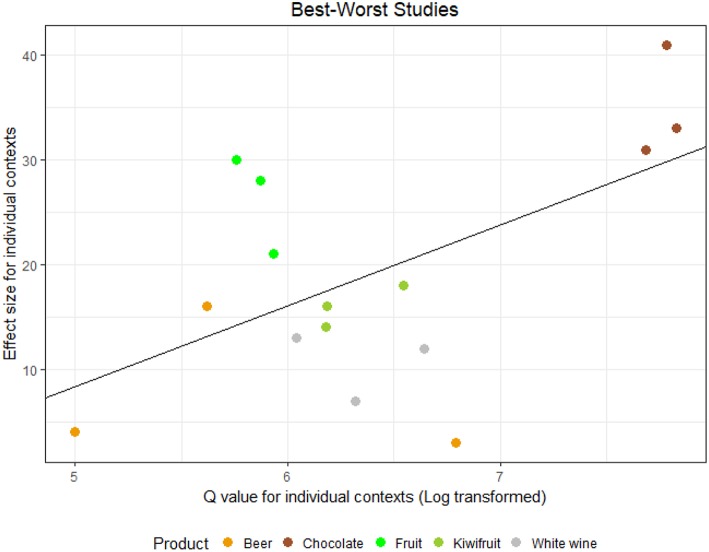
Size of the difference in appropriateness (Cochran's Q) plotted against effect size (R2) for studies 6b–10b, with superimposed line of best fit (y = −30.1 + 6.7x, R2 = 31%, p = 0.029).